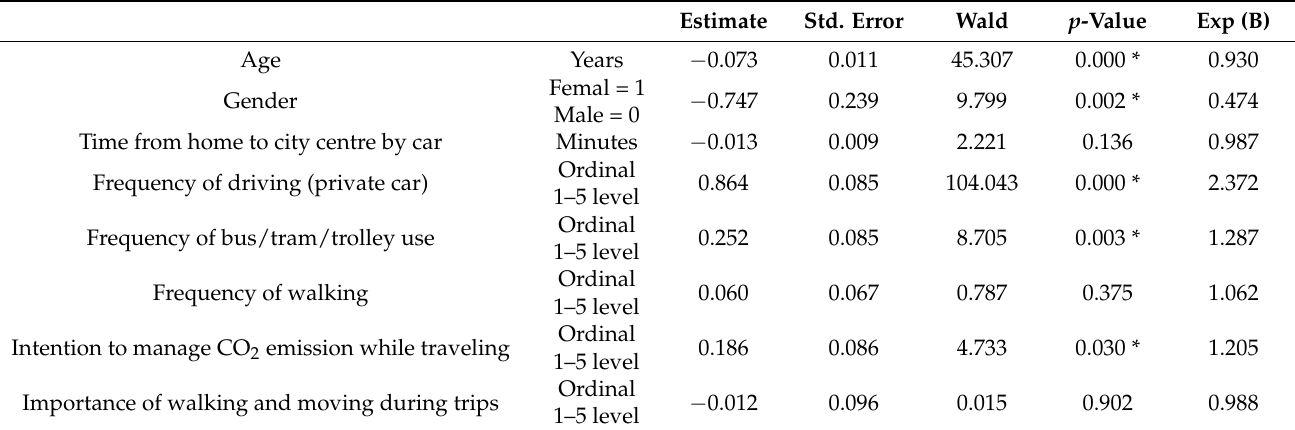
Table 10. Ordinal regression model for the frequency of car-sharing